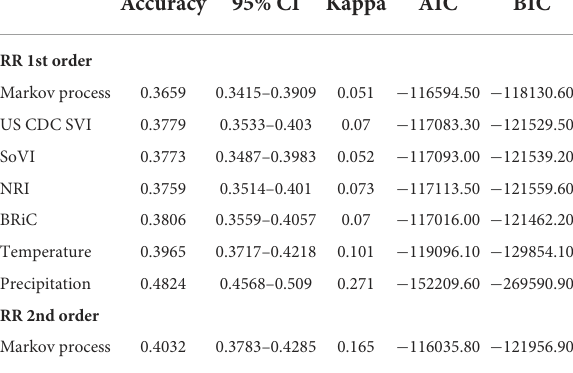
TABLE 2 Variables added to DBN